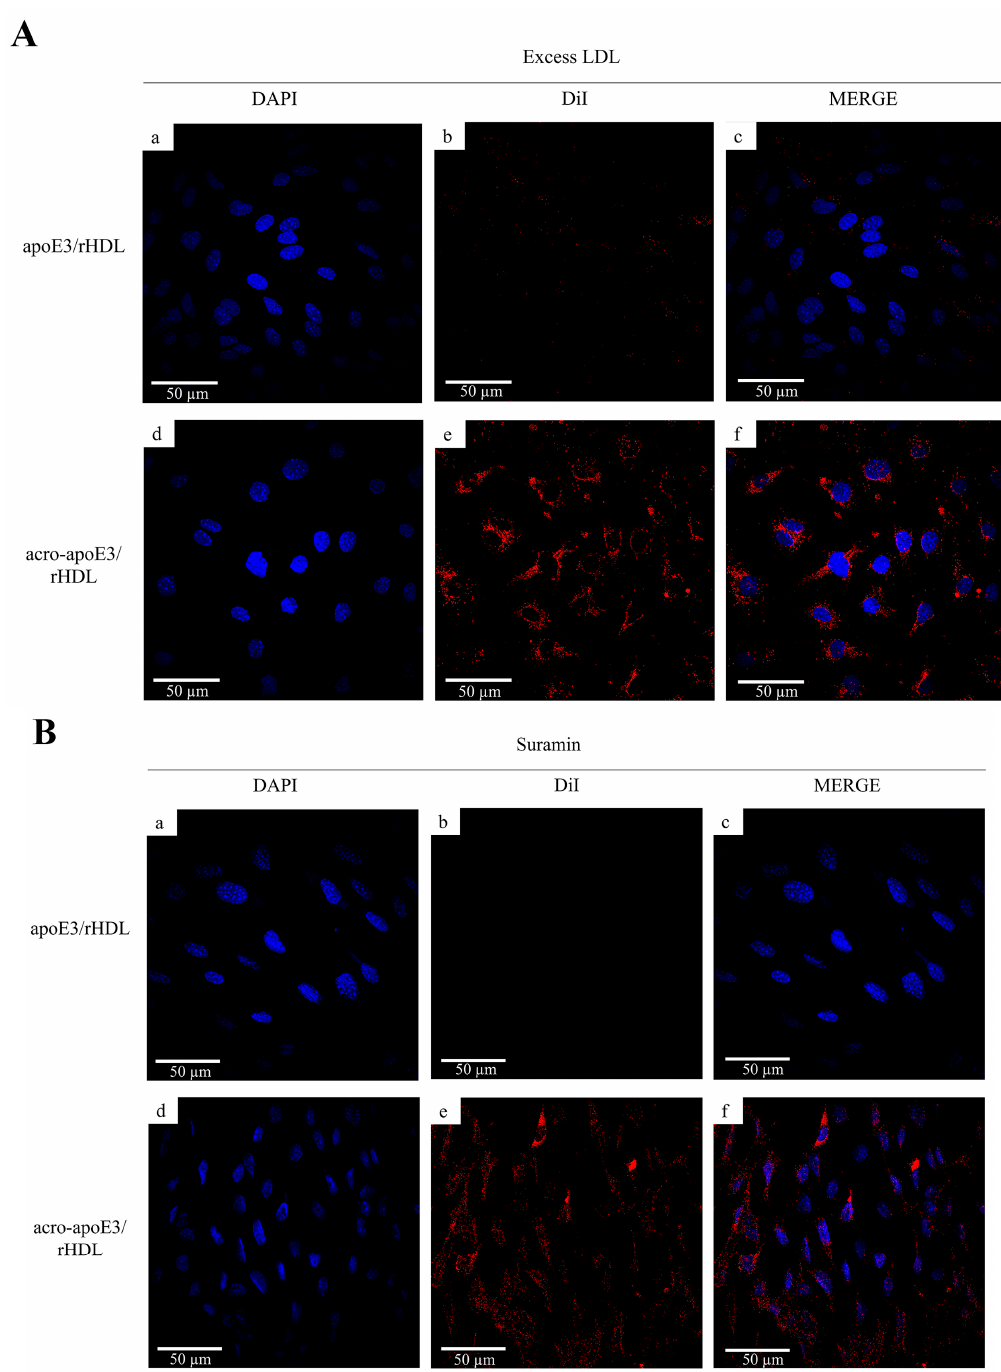
Figure 5. Uptake of apoE3 / rHDL and acro-apoE3 / rHDL by bEnd.3 cells. Uptake was followed by direct fluorescence in the presence of excess LDL ( A ) or suramin ( B ). Uptake experiments were carried out in the presence of 100 × excess LDL or 2mM suramin and apoE3 / rHDL (a–c) or acro-apoE3 / rHDL (d–f) (apoE3 concentration: 3 µ g / mL). The panels show fluorescence of DAPI (a,d), DiI (b,e), and Merge (c,f).